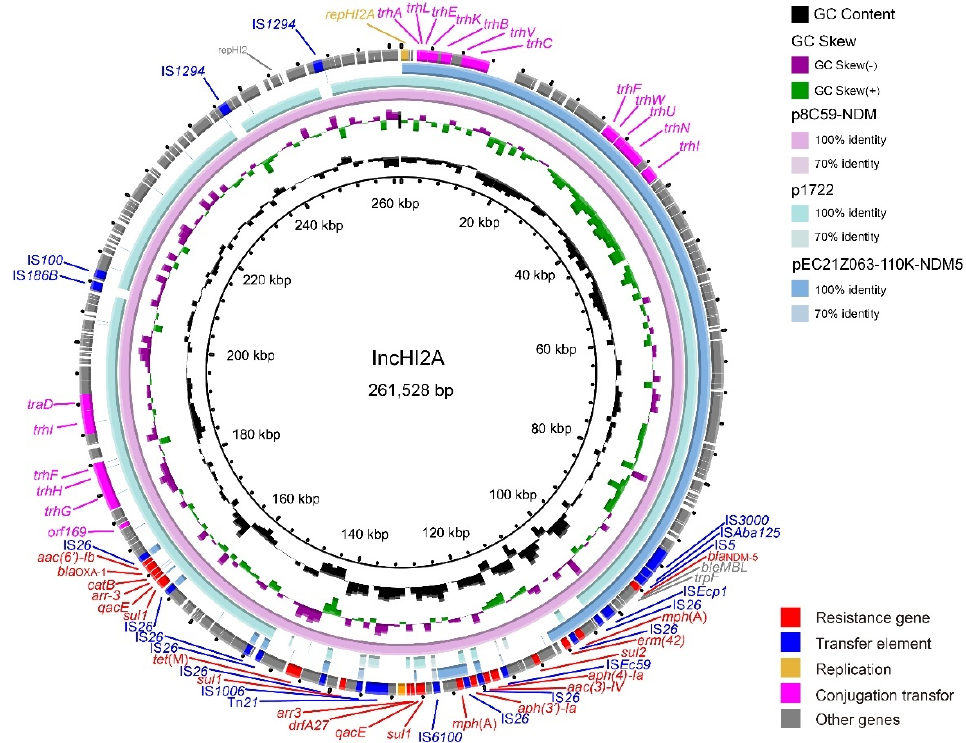
Figure 7. Genetic characteristics of the bla NDM-5 -positive plasmid pEC21Z063-110K-NDM5 identified in this study compared with similar plasmids from pathogenic bacteria in humans or animals. The arrows and triangles represent genes from different functional categories (red: ARGs, dark blue: insertion sequence, orange: replication, pink: conjugation transfer, grey: other genes).